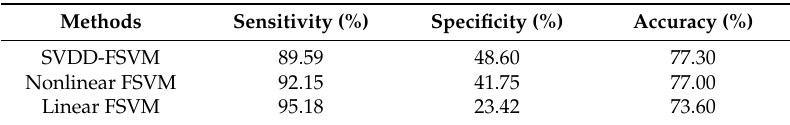
Table 3. Performance on the German test data